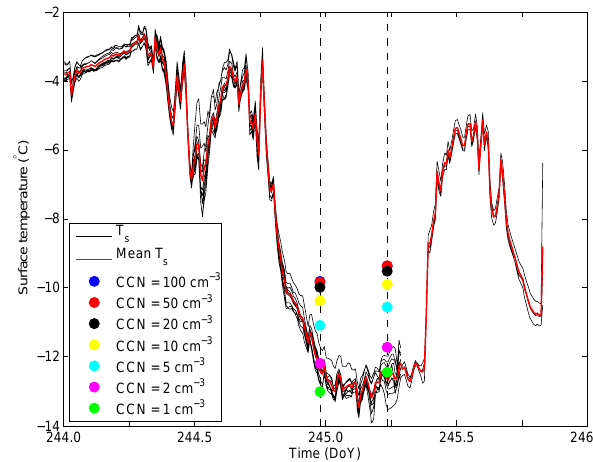
Fig. 11. Surface temperature observations from 10 different thermo- couples (faint black lines), and their mean (red line). The coloured dots show surface temperature from the SCM experiments with var- ious CCN